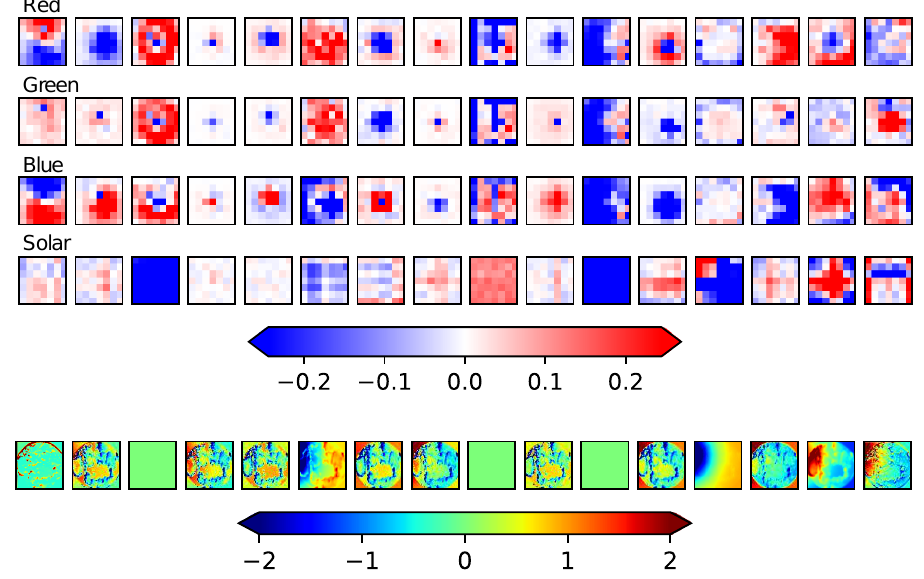
Figure A3. Upper panels show the multi-channel filters in the first convolution layer (A2) shown in Figure 9. Each column corresponds to one of 16 filters, and each row corresponds to one of four input channels. The filter size is 7 × 7 pixels, and the color shades represent the filter weight. The lower panels show output feature maps with a size of 128 × 128 pixels for the case shown in Figure A2, where each image corresponds to the above multi-channel convolution filters. Each feature map shows normalized signals with a mean of 0 and standard deviation of 1, except for the third, ninth, and eleventh ones from the left, for which the standard deviation is less than 10 –35 .